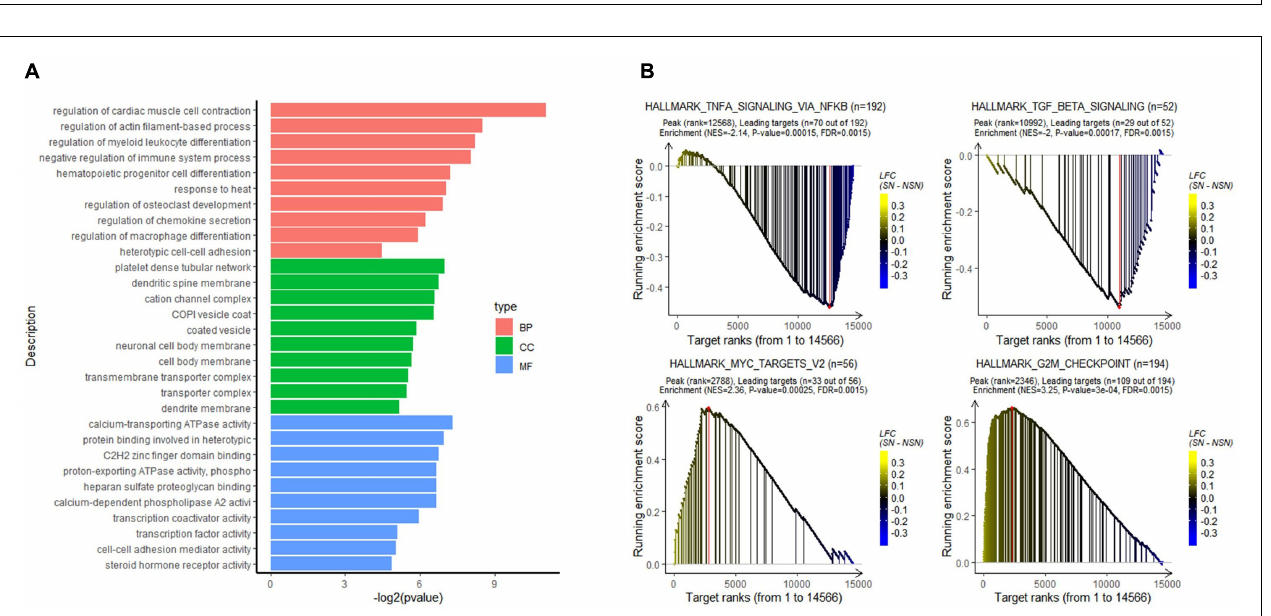
FIGURE 2 | Results of functional enrichment analysis. (A) Gene Ontology (GO) analysis of the DEGs. (B) gene set enrichment analysis (GSEA) of all expressed genes using the GSEA hallmark pathways database.